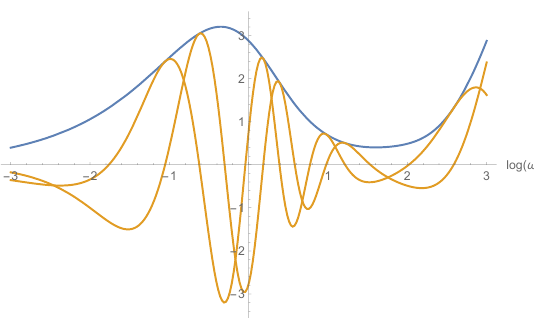
Figure 5 . Plots of absolute value (blue) and real and imaginary parts (orange) of G ( !; 1) over ! in the d = 4 parabolic case. No zero is observed for ! >